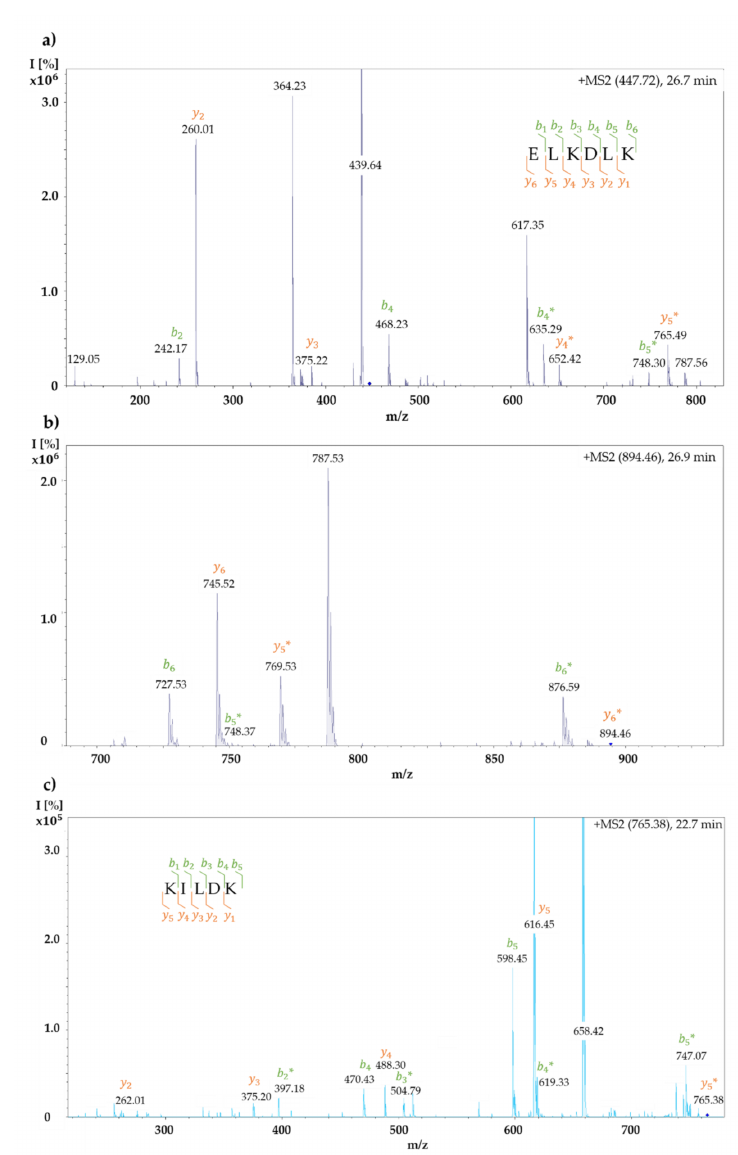
Figure 9. MS/MS spectra of the singly modified peptides ELKDLK of [M + 2H] 2+ with m / z 447.72 ( a ) and of [M + H] + with m / z 894.46 ( b ) and KILDK of [M + H] + with m / z 765.38 ( c ). The b -fragment ions are shown in green and the y -fragment ions are shown in